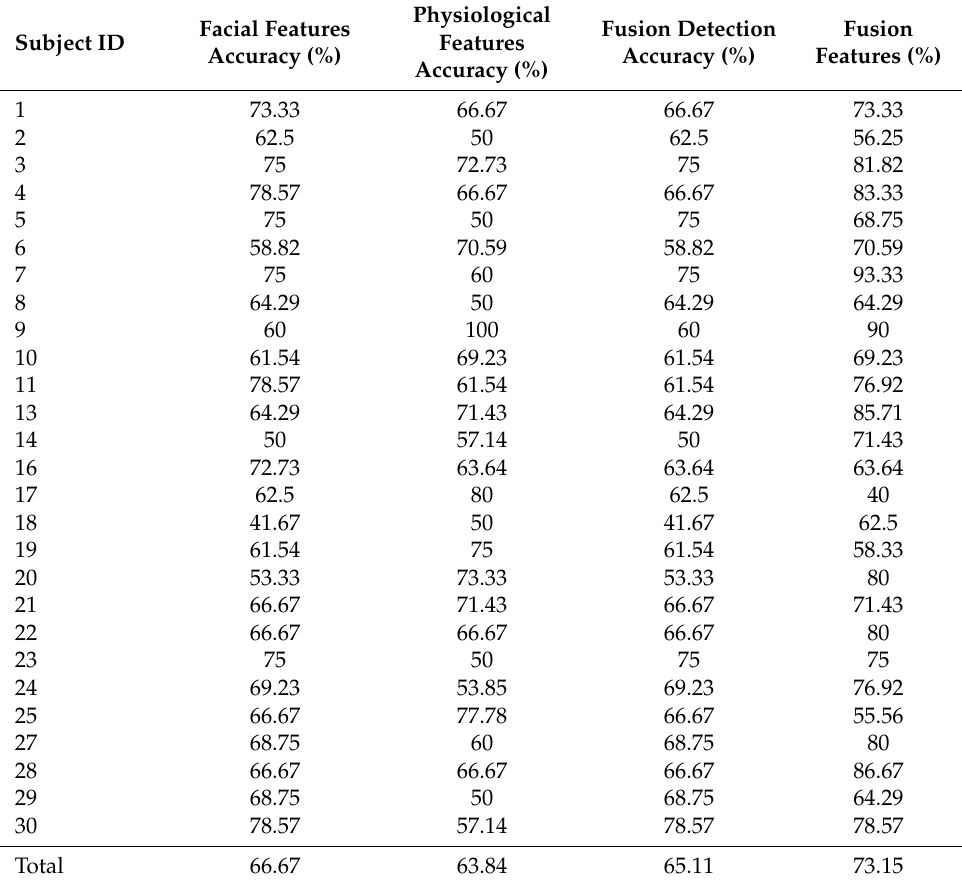
Table 2. Video valence classification accuracy in Mahnob-HCI dataset using